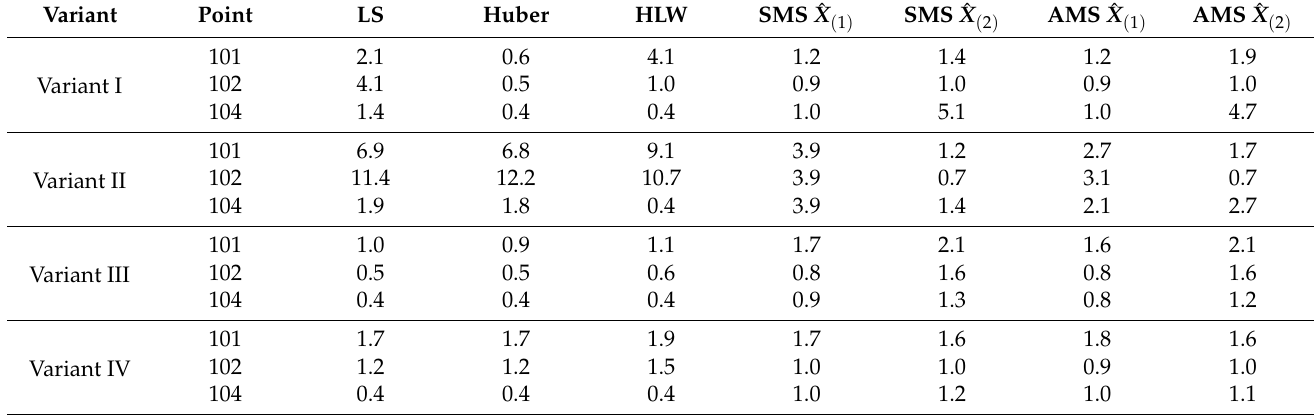
Table 2. RMSDs (mm) of the chosen object point height estimates from